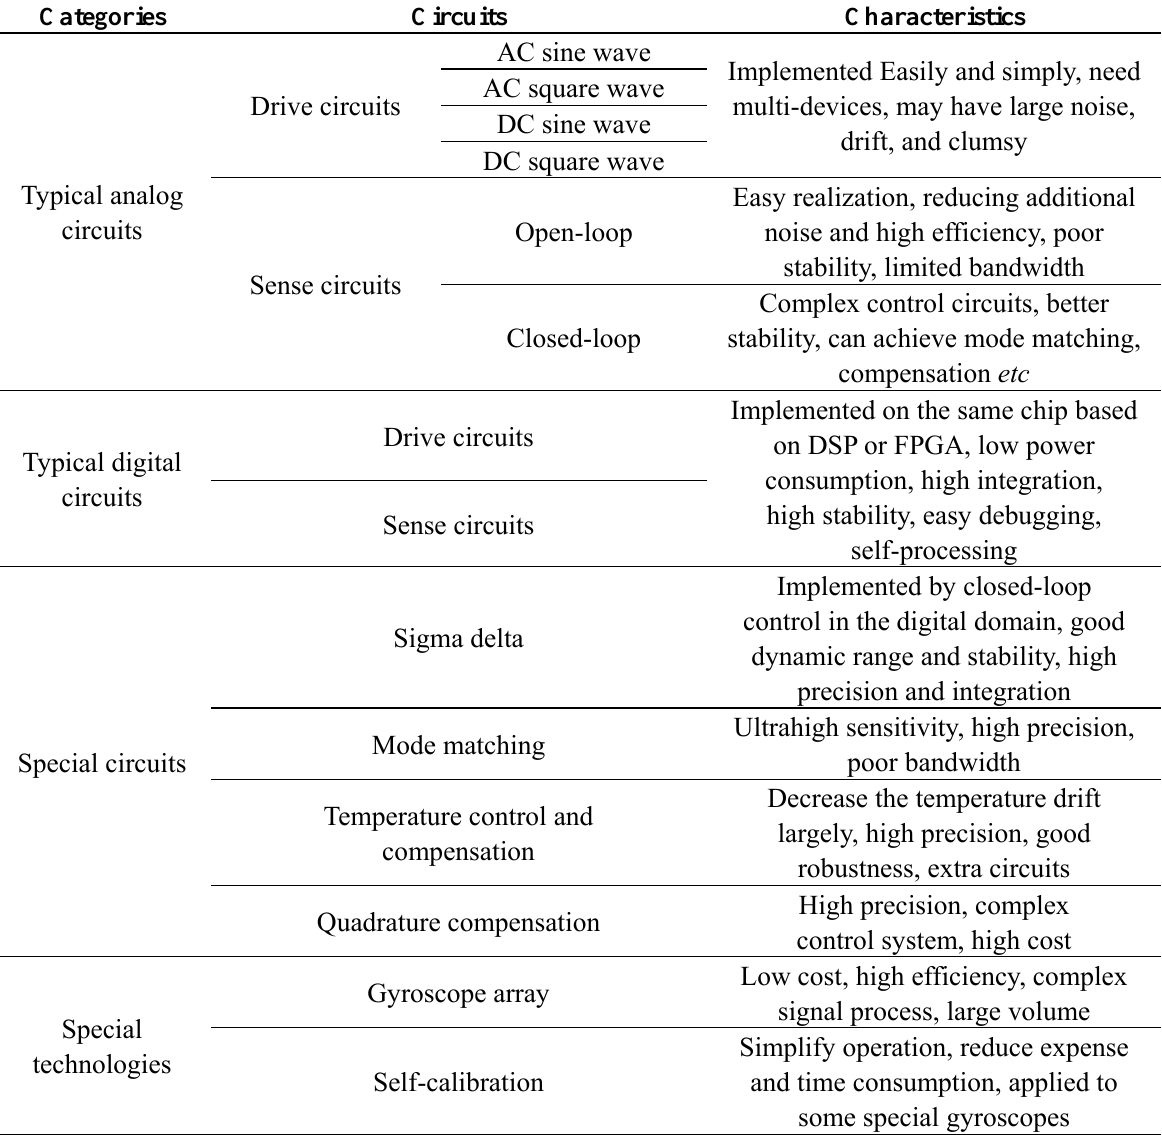
Table 12. Summary of circuits used in micromachined